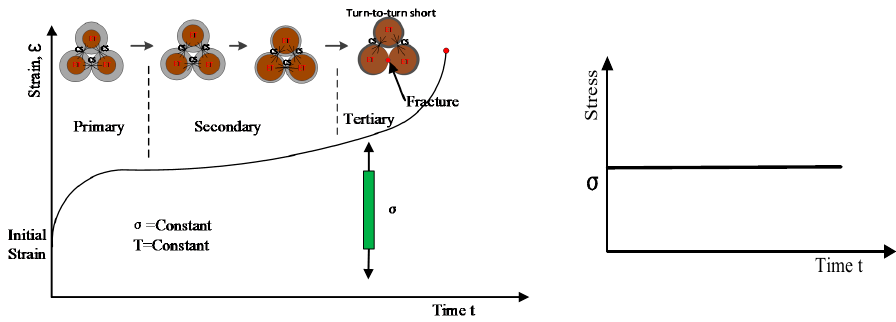
Figure 5. Idealized creep curve of plastics under constant temperature and constant load.